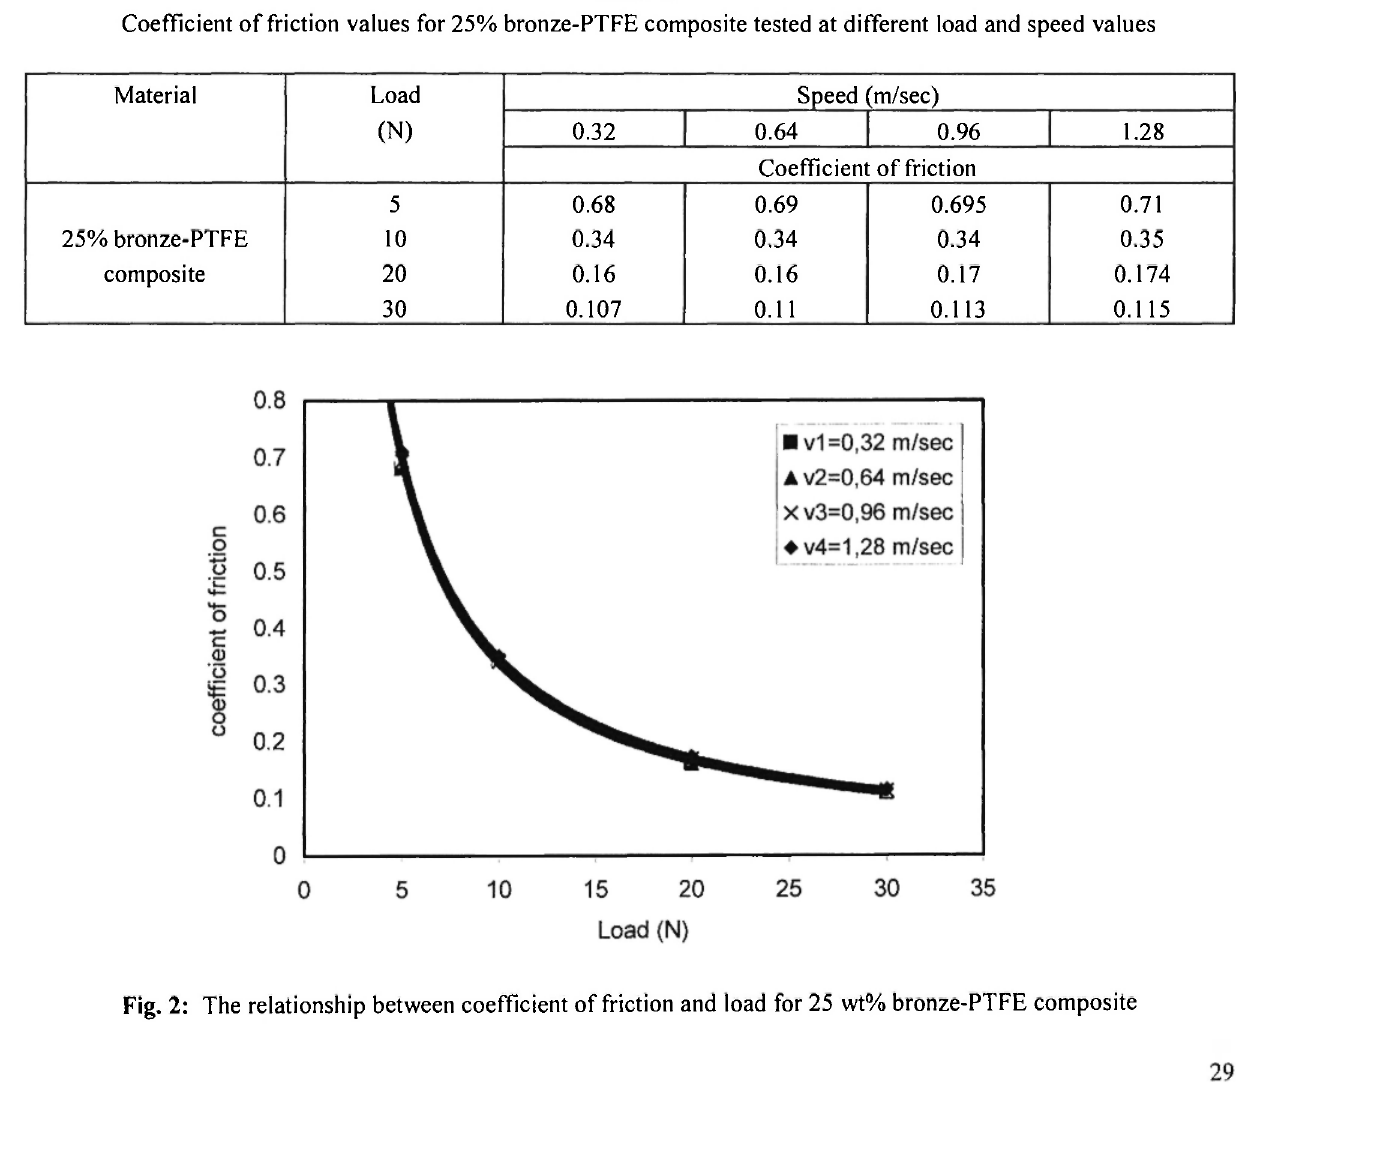
Fig. 2: The relationship between coefficient of friction and load for 25 wt% bronze-PTFE